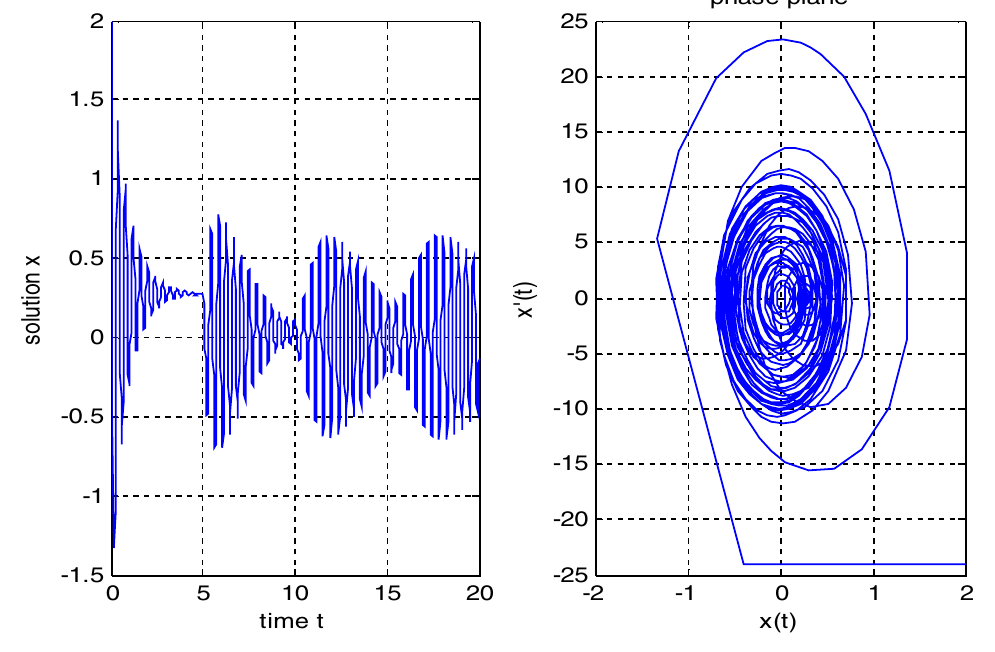
a 1 x(t a 2 x(t τ 1 ) τ 2 ) dt = − + −